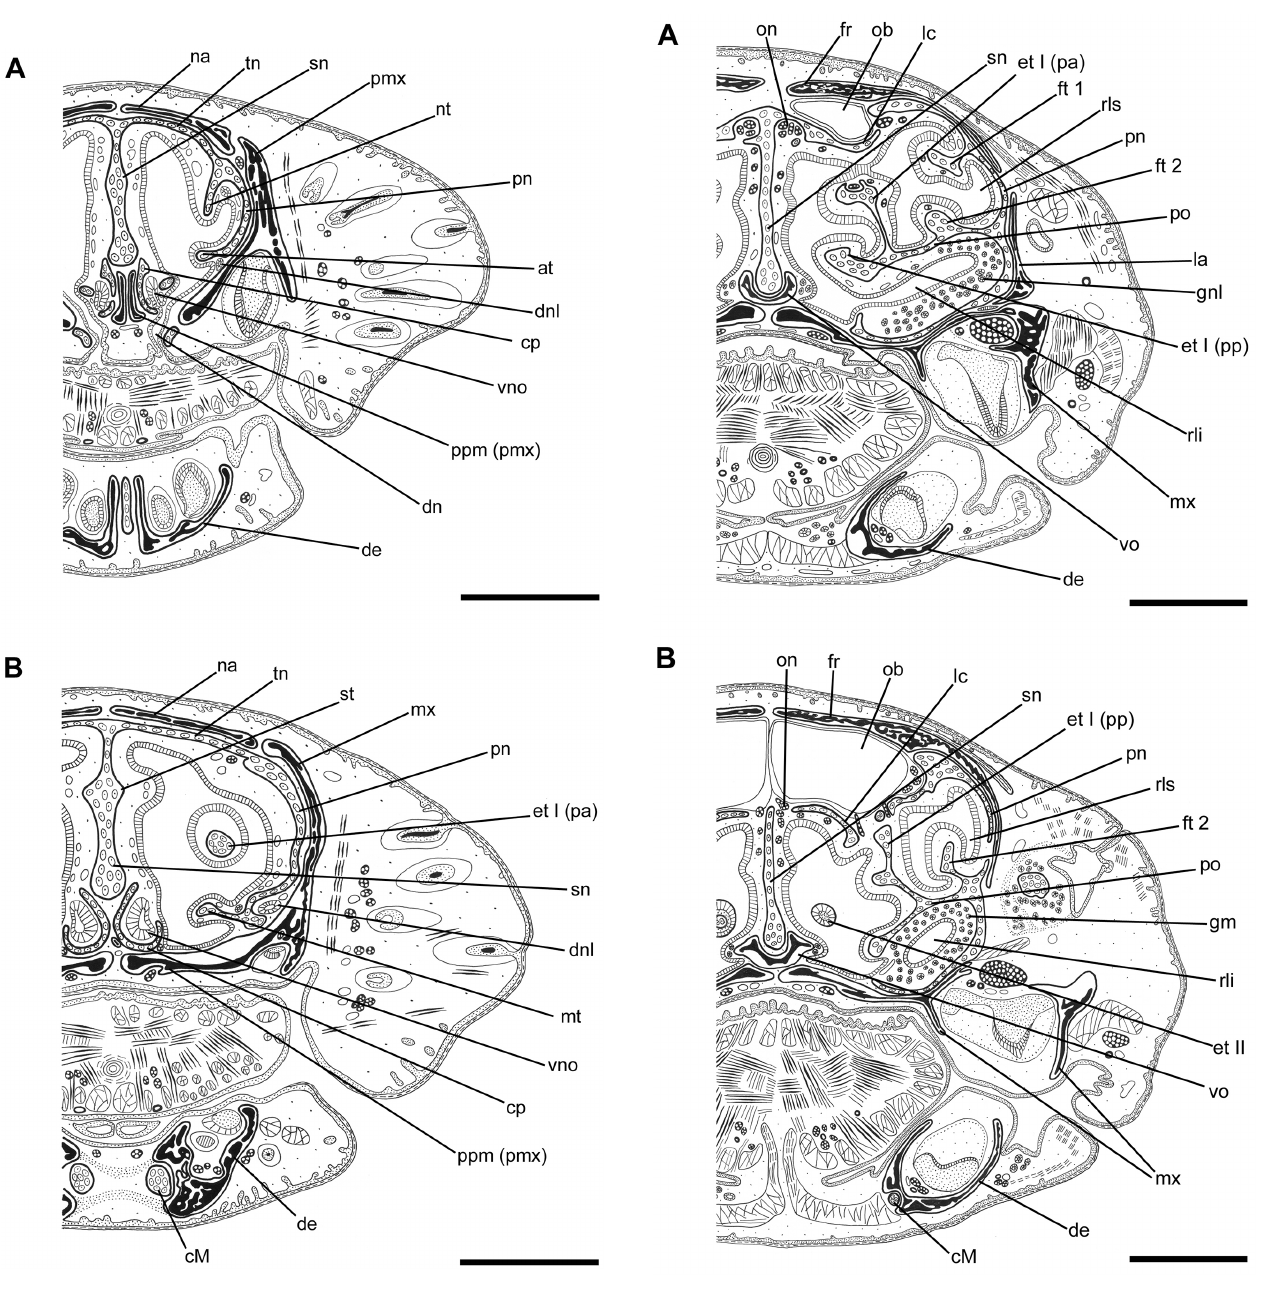
Figure 6. Drawings of histological cross sections through the pars lateralis and posterior of the fetal nasal cavity from anterior (a) to posterior (b) of Ptilocercus lowii (30mm CRL). Abbreviations: cM, cartilago Meckeli; de, dentary; et I, II, ethmoturbinal I, II; fr, frontal; ft 1, 2, frontoturbinal 1, 2; gm, glandula maxillaris; gnl, glandula nasi lateralis; la, lacrimal; lc, lamina cribrosa; mx, maxilla; ob, ol- factory bulb; on, olfactory nerves; pa, pars anterior; pn, paries nasi; po, pars obtecta (paries conchalis); pp, pars posterior; rli, recessus lateralis inferior; rls, recessus lateralis superior; sn, septum nasi; vo, vomer. Scale bars equal